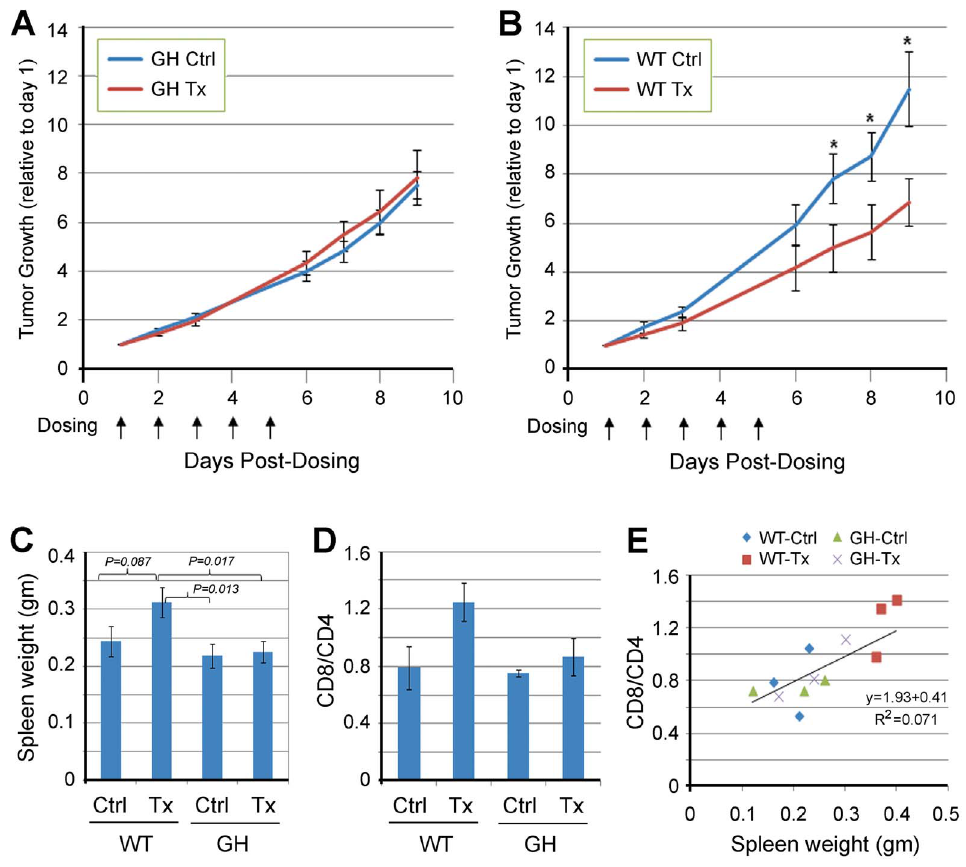
Figure 4. Immunogenicity of ffLuc-eGFP alters the response of tumors to chemotherapeutic agents in wildtype mice compared to GH mice. Labeled LLC tumors were inoculated subcutaneously into WT and GH c-Brd mice. When the average tumor size reached 125 mm 3 , each strain of mice was randomized into two groups to receive either control vehicle (Cremophor EL + saline) or paclitaxel. Tumor size was measured periodically. A and B , Tumor growth (fold-increase relative to day 1) in WT and GH c-Brd mice (mean 6 SE). Paclitaxel treatment was inefficacious in GH mice ( A ), but delayed tumor growth in WT mice (*, P , 0.05 in a two-tailed T-test) ( B ). Ctrl, control vehicle; Tx, paclitaxel treatment. C , Spleen size in each group (mean 6 SE). Spleens in paclitaxel-treated WT c-Brd mice were marginally bigger than those in vehicle-treated c-Brd mice but significantly bigger than those in both groups of GH mice. No significant difference was found between the two GH mouse groups. D and E , Enlarged spleens in paclitaxel-treated WT mice correspond to higher CD8/CD4 ratios. Splenocytes were prepared from spleens harvested from mice from each treatment group. These were stained with anti-mouse CD4 or CD8 antibodies, and analyzed by flow cytometry and Cellometer to obtain the ratio of the CD8 + to CD4 + subpopulation (CD8/CD4) in WT and GH c-Brd host mice (mean 6 SE) ( D ). E , Regressional analysis demonstrated a significant correlation between CD8/CD4 ratio and spleen size ( P , 0.01).